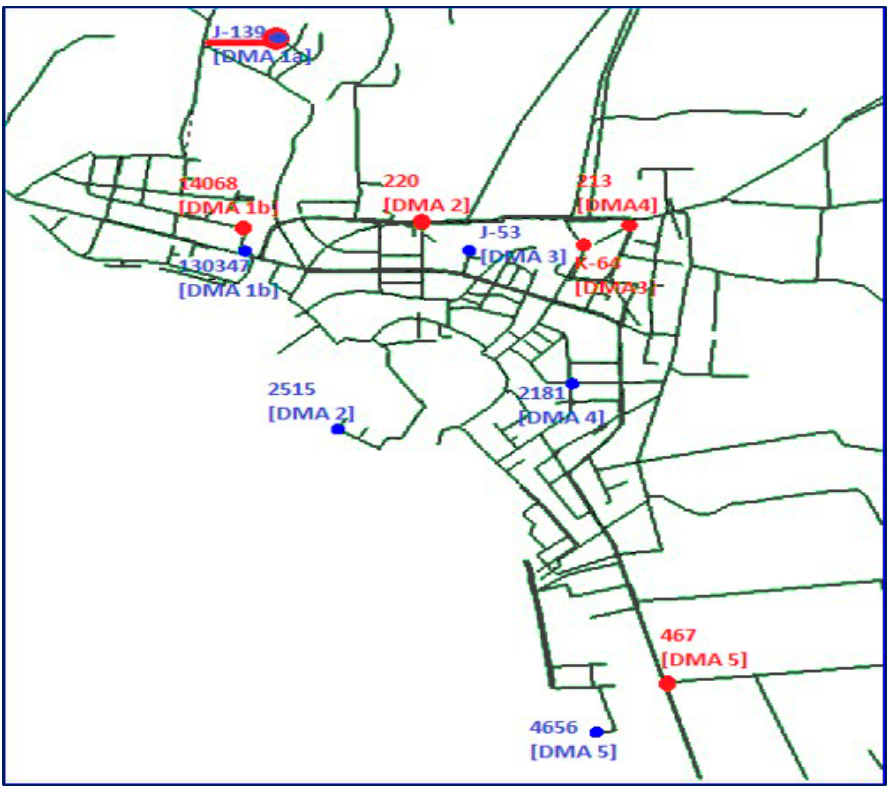
Figure 5. Scenario No3_Pressure critical nodes (red) vs. Age critical nodes (blue). Table 4. Water age and water demand values per DMA and for the entire water distribution network (WDN) for each one of the three scenarios studied.